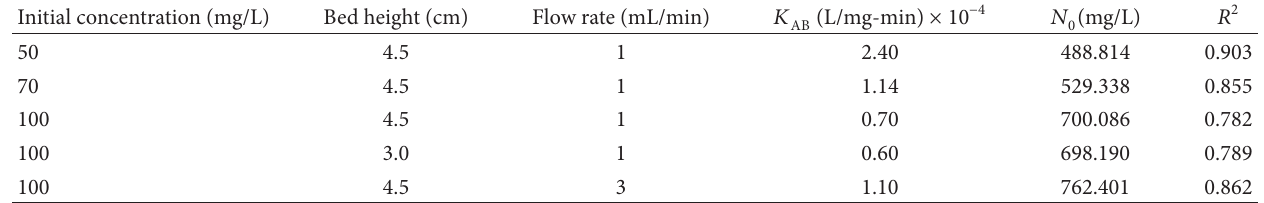
T 5: Adams-Bohart parameters for manganese(II) at different conditions using linear regression analysis. Initial concentration (mg/L)